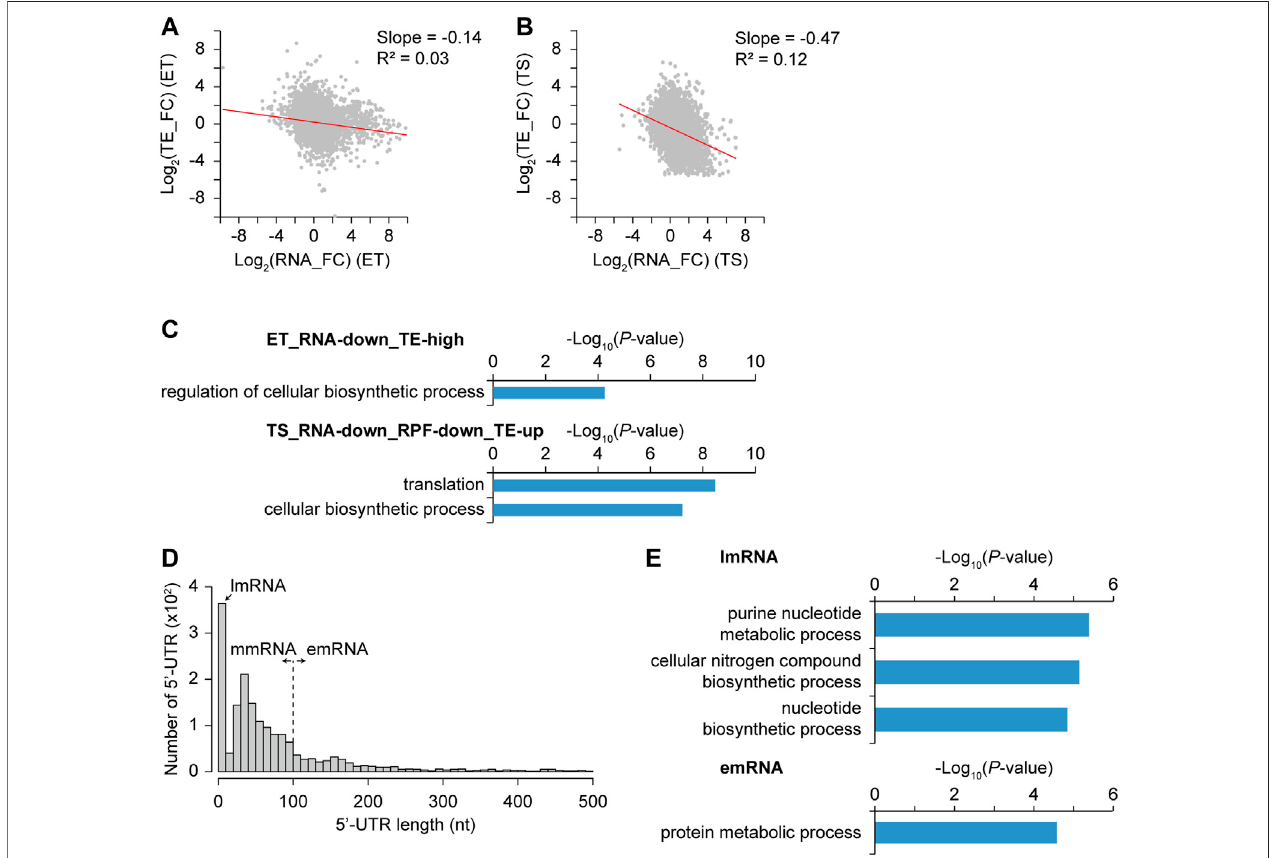
FIGURE6 | Differential transcriptionef fi ciency (TE) and its correlationwith genefunctions and 5 ′ -UTR length. (A – B) Correlationbetween log 2 RNA foldchange and log 2 TEfoldchangefrom (A) EtoTphaseand (B) TtoSphase.Trendline(red)withtheirslopeandR-squaredvaluewasindicated. (C) DifferentTEgenegroupsandtheir selected enriched gene functions of each group were represented with their − log 10 p -value (GO-term enrichment, GO_Biological_Processes, hypergeometric test, Benjamini and Hochberg False Discovery Rate (FDR) correction ( q < 0.05)). (D) 5 ′ -UTR length distribution of genes with primary TSSs. They were classi fi ed based upon their 5 ′ -UTR length, which are lmRNA (leaderless mRNA, 0 – 10 nt), mmRNA (moderate-leadered mRNA, 11 – 100 nt), and emRNA (extended-leadered mRNA,